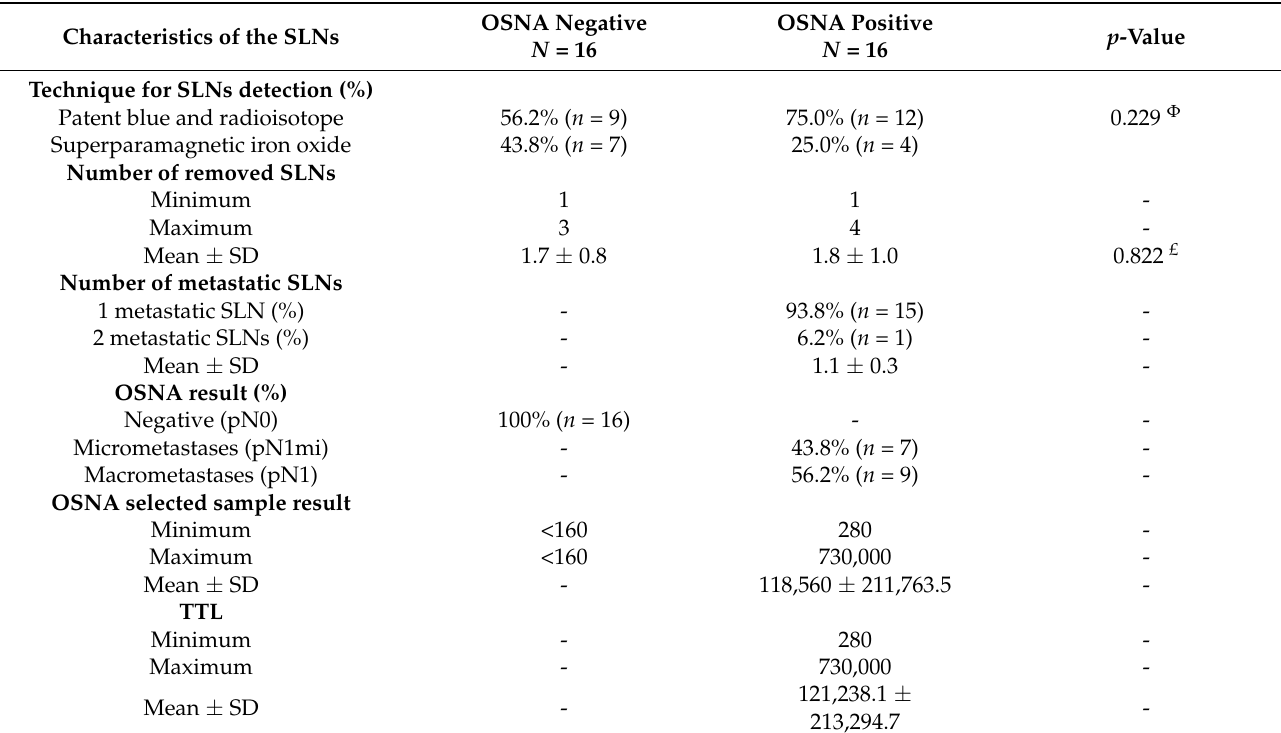
Table 3. Characteristics of the SLNs, comparing patients with OSNA negative SLNs (pN0) and patients with OSNA positive SLNs (pN1mi and pN1).